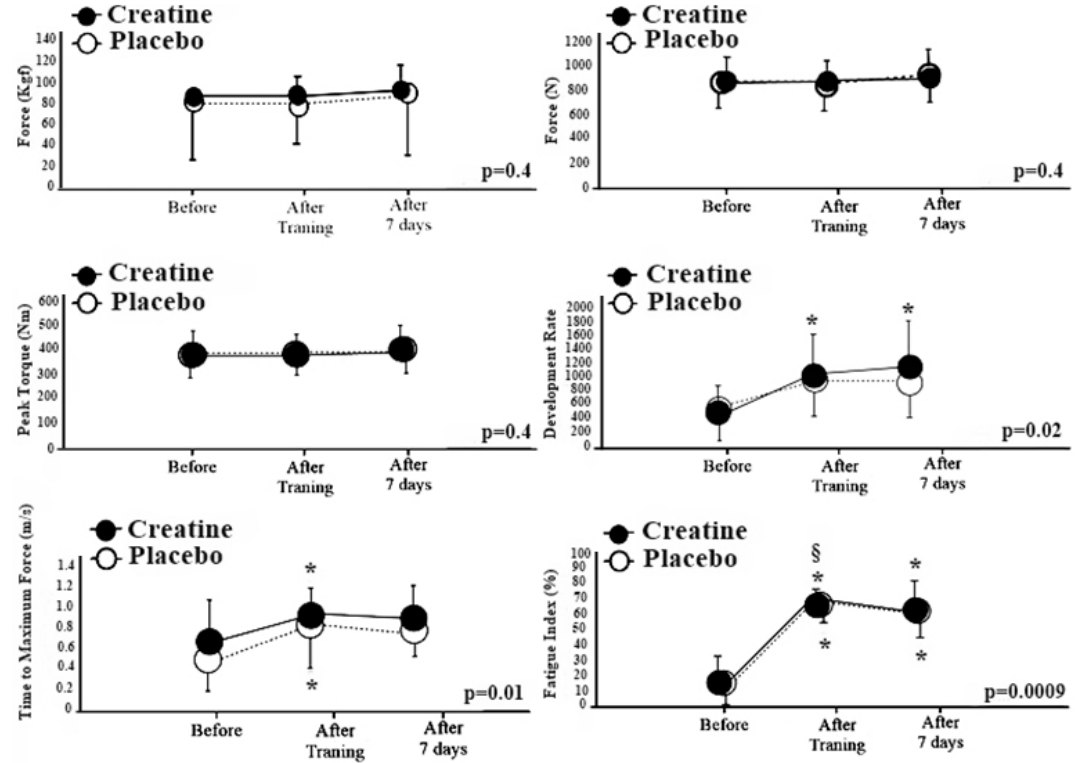
Figure 2. Intra-condition comparisons regarding force indicator at different times. Kgf = Kilograms force. N = Newtons. Nm = Nanometer. p = Value of the degree of statistical significance. m/s = Meters per Second. % = Percentage. * = Significant differences for the before condition. § = Significant difference for the after 7 days condition. p = Value of the degree of statistical significance.